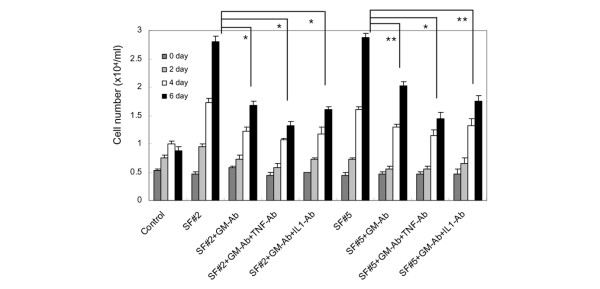
Inhibitory effects of neutralizing antibodies to cytokines on the SF-mediated proliferation capacity of RA FLSs. Rheumatoid arthritis (RA) fibroblast-like synoviocytes (FLSs; 2–14) at passage 12, at a concentration of 5 × 103 cells per well in a 24-well plate, were cultured in the presence of synovial fluid (SF) at a dilution of 1/10 or in the presence of SF together with anti-granulocyte – macrophage colony-stimulating factor (300 ng/ml), anti-IL-1β (500 ng/ml) or anti-TNF-α (2 μg/ml) neutralizing antibodies. RA FLSs were preincubated for 1 hour with these neutralizing antibodies. Two different SFs were added every 2 days in the presence or absence of neutralizing monoclonal antibody. Cells were harvested every 2 days and their viability was assessed by trypan blue staining. The results are means ± SD obtained from single experiments performed in triplicate cultures. *p < 0.01; **p < 0.05.